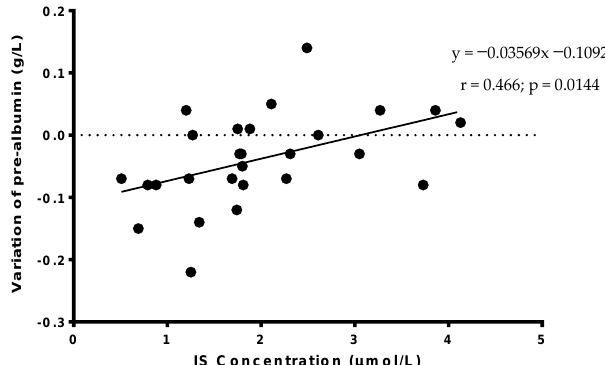
Figure 2. Correlation between serum IS concentrations of AUD patients at the treatment entry and variations of serum prealbumin concentrations during alcohol withdrawal. Statistically significant at p < 0.05.